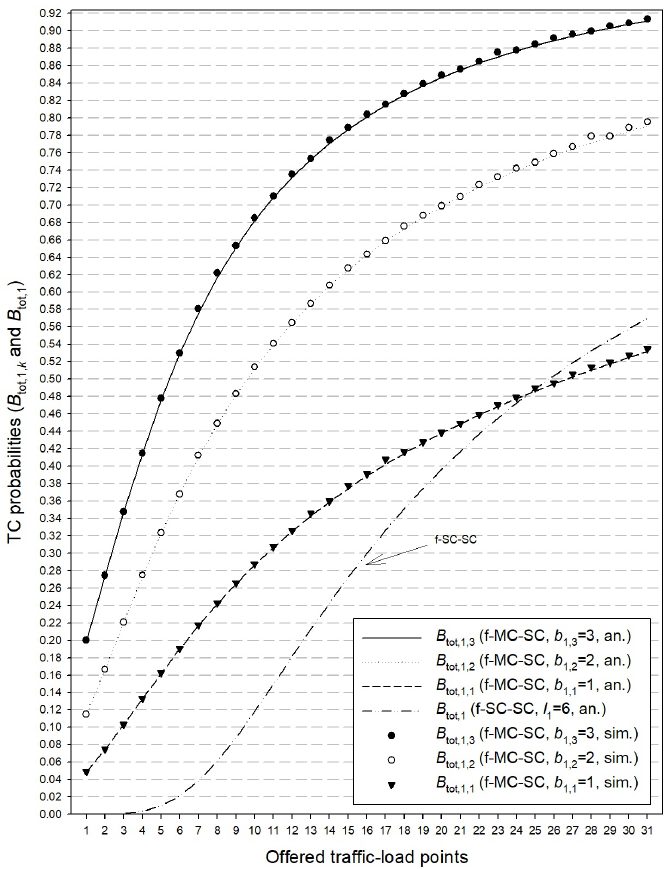
Figure 7. Total TC probabilities (1st RRH—all service classes).